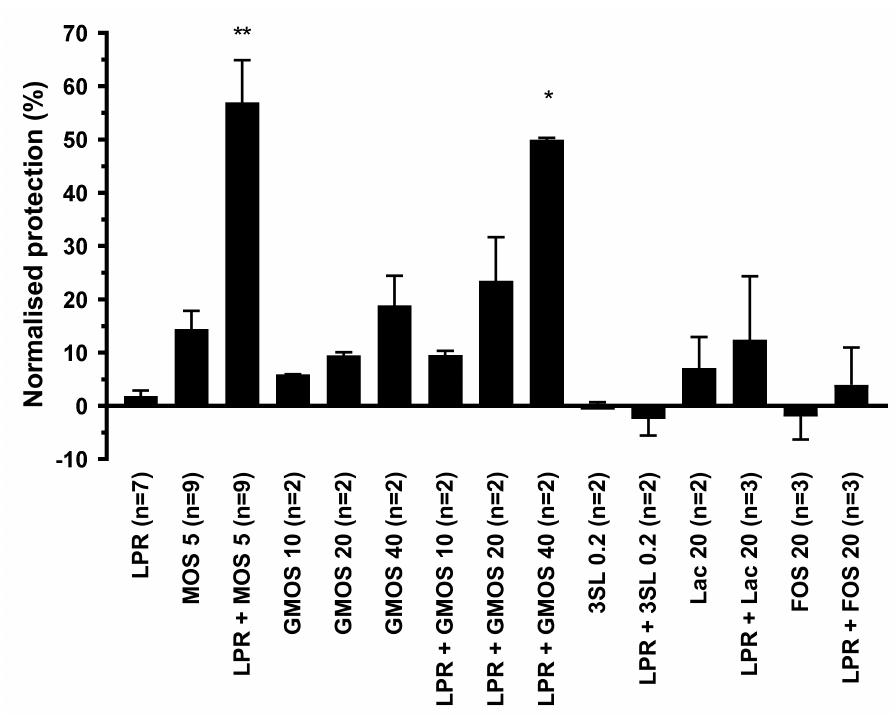
Figure 2. Protection of T84 epithelial cells from barrier integrity damage by C. di ffi cile toxin A. T84 cells were preincubated for 2 h with MOS, GMOS, Lactose (Lac) or 3 (cid:48) Sialyllactose (3 (cid:48) SL) in the absence or presence of 10 5 / mL L. rhamnosus (LPR) prior to the addition of C. di ffi cile toxin A. T84 transepithelial resistance was measured before sample addition and after 20 h in the presence of toxin A. Protection of resistance was normalized to that of T84 in media alone (0%) and MRS (100%). Data are expressed as mean ± SEM, number of independent experiments with n = 2 replicates each are indicated in the figure legend ( n = 2–9). Statistical di ff erence to LPR alone are indicated (One-way ANOVA on ranks with Dunn’s multiple comparison test) * p < 0.05, ** p <